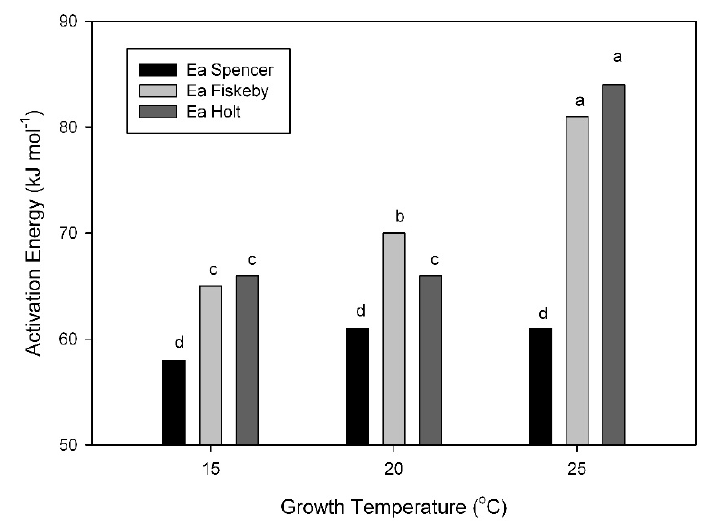
Figure 5. The activation energy (Ea) of the maximum carboxylation capacity (V Cmax ) of Rubisco based on C i , for three cultivars of soybean grown at three temperatures (15, 20, or 25 °C). Each column represents a mean for 3 or 4 leaves. Different letters indicate significant differences at P = 0.05, using analysis of variance.